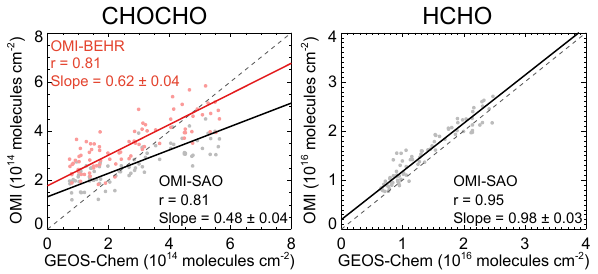
Figure 8. Scatterplots of OMI vs. GEOS-Chem CHOCHO and HCHO columns over the eastern US (75–100 ◦ W, 29.5–45 ◦ N). Val- ues are seasonal means for JJA 2006–2007 as plotted in Fig. 7. OMI observations for CHOCHO are from the standard SAO retrieval (Chan Miller et al., 2014) and using BEHR scattering weights (Rus- sell et al., 2011; Laughner et al., 2016). Correlation coefficients and reduced-major-axis (RMA) regressions are